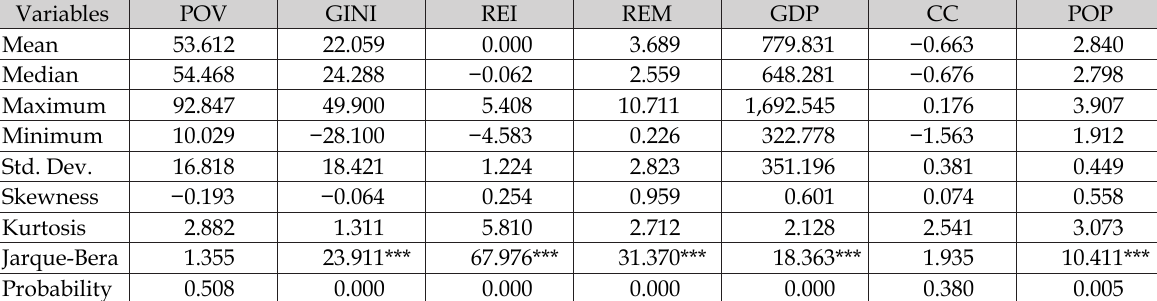
Table 2. Descriptive statistics.